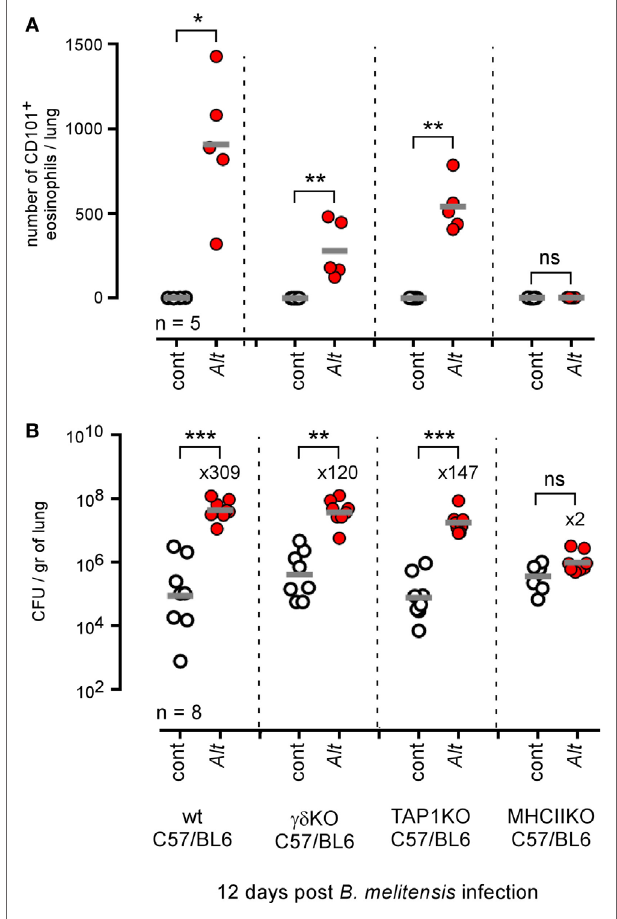
FigUre 6 | Impact of T lymphocyte deficiency on Alt -induced Brucella susceptibility. Wild-type, γδ TCR − / − , TAP1 − / − , and MHCII − / − C57BL/6 mice received repeated i.n. administration of phosphate-buffered saline or Alt before i.n. infection with 2 × 10 4 CFU of mCherry- Brucella melitensis . The mice were sacrificed at 12 days post infection. (a) The data represent the number of eosinophils recruited (SIGLEC-F + CD11c − CD101 + ) × 10 5 per lung from each group as determined by flow cytometry. (B) The data represent the number of CFU/gr of lung at 12 days post infection from each group. Horizontal gray lines represent the medians. n denotes the number of mice used for each lineage. These results are representative of at least three independent experiments. * p < 0.05, ** p < 0.01, *** p <